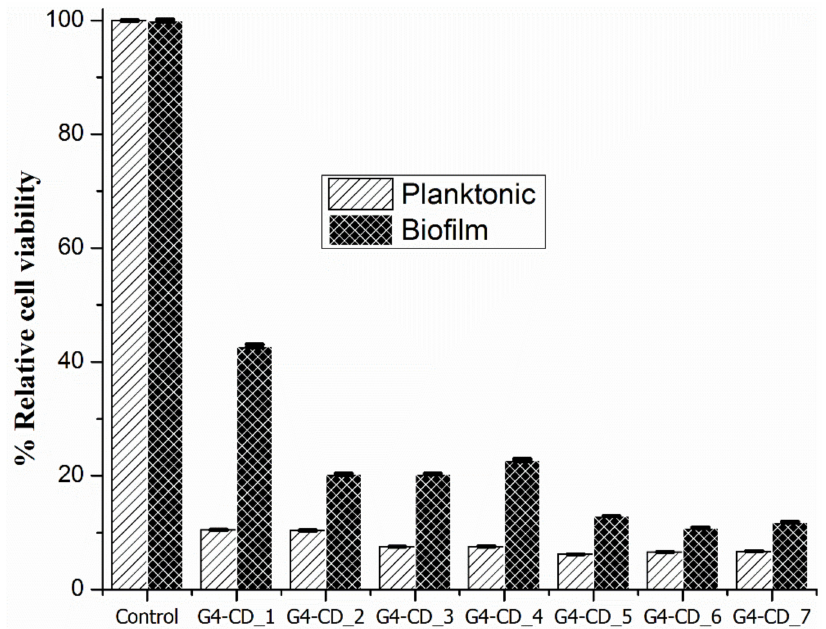
Figure 9. Relative cell viability of S. aureus in planktonic and biofilm phase after incubation with G4–CD_1–7